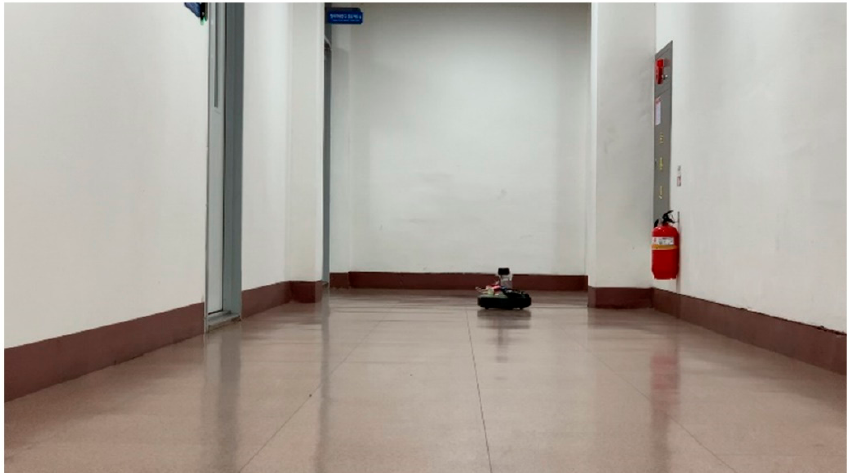
Figure 18. Position (marked 4 in Figure 15) in indoor space where first autonomous scanning experiment was performed.